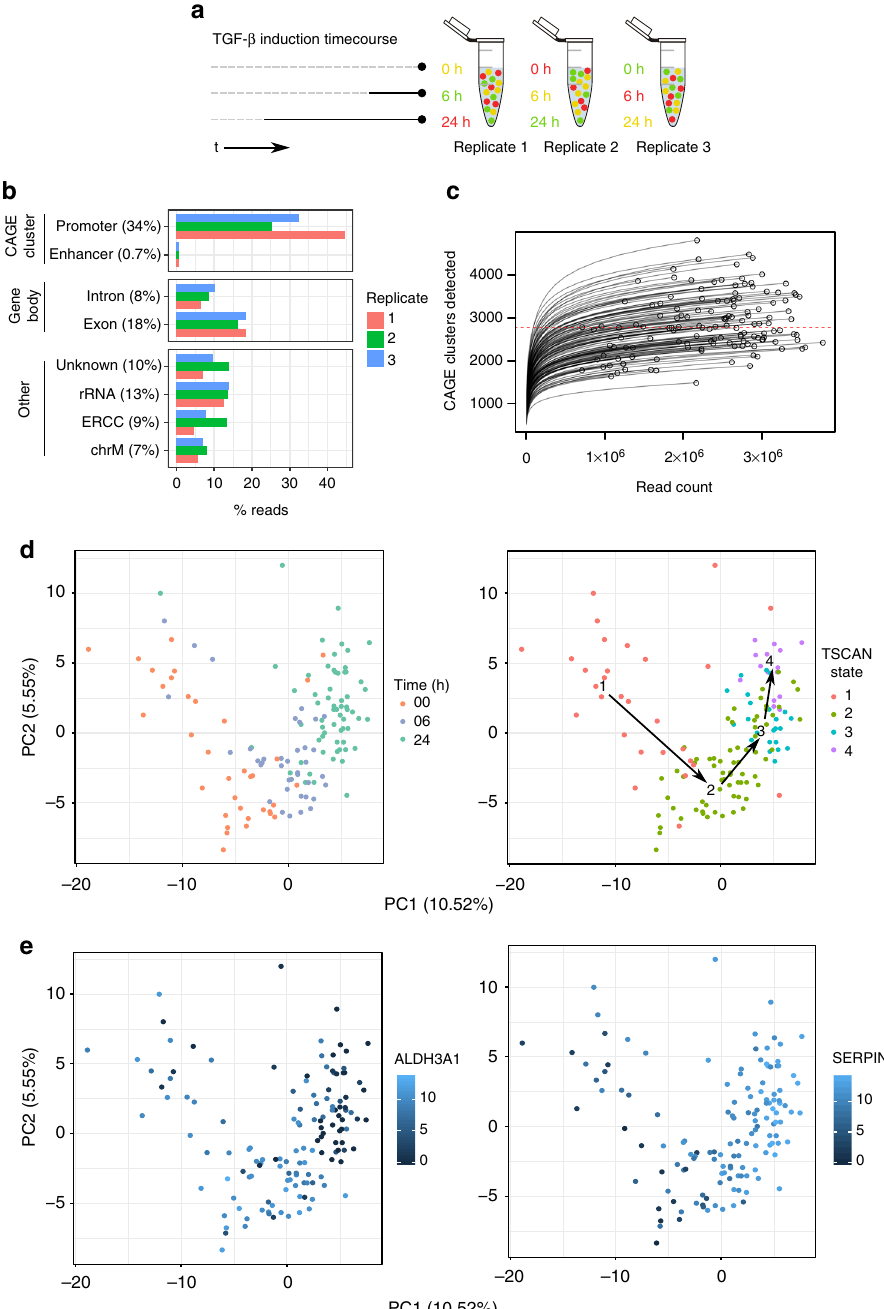
Fig. 2 Multiplexing time course strategy. a Different combinations of Calcein red and green are added to each timepoint for each replicate. b Forward read 5 ʹ -end counts by annotation category. Mean read percentage per category shown in brackets. c Count of CAGE clusters within each cell after subsampling. Dashed red line at median (2788). d PCA of cells performed on variable subset of CAGE clusters, percentage of variance explained by components shown, cells colored by time point and TSCAN state. e PCA of cells performed on variable subset of CAGE clusters, percentage of variance explained by components shown, cells colored by expression values for the marker genes ALDH3A1 and SERPINE1 demonstrating that the dynamics of TGF- β response are captured by the TSCAN states. Source data are provided as a Source Data fi CAGE clusters detected per cell (Fig. 2c). To demultiplex time components analysis (PCA), where cells cluster by replicate points, we localized the cells in their capture chambers on the (Supplementary Fig. 4a). However, our cell labeling design IFCs and quanti fi ed their fl uorescence in the red and green ensured that each replicate contained cells for each time point, channels, identifying 40, 41, and 70 cells for time points 0, 6, and allowing us to correct for this batch effect using linear modeling. 24 h, respectively. Following the scran pipeline 26 we removed 15 After batch correction cells were clustered by time points rather unreliable cells, arriving at the fi nal set of 136 high-quality cells. than by replicate (Supplementary Fig. 4b). After removing low Initially, we observed a strong batch effect with principal abundance CAGE clusters, our fi nal dataset detected 18,687